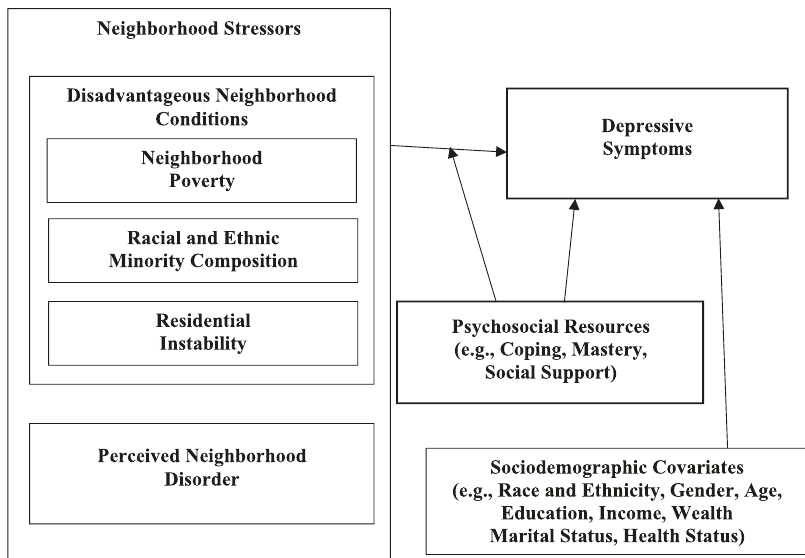
Fig. 1 A Conceptual Model of Neighborhood Stressors and Depressive